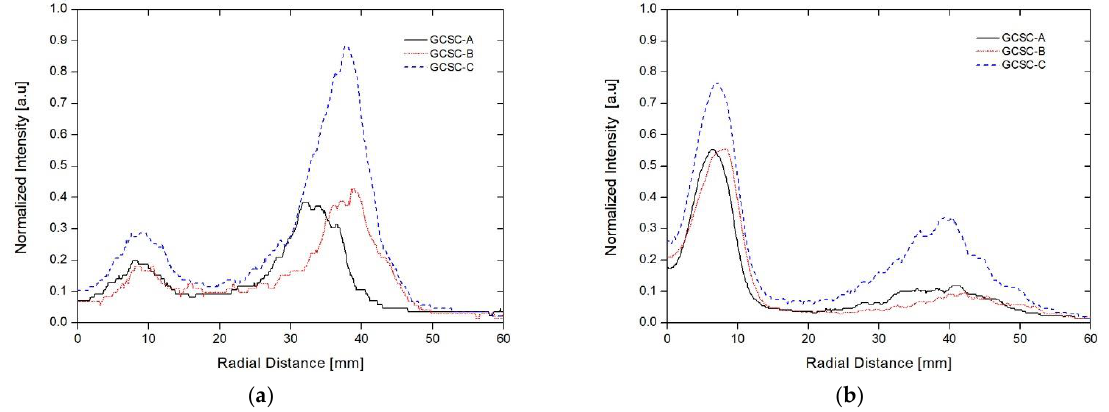
Figure 5. Spray distribution of the radial section at 30 mm from injector face: ( a ) MFR = 15; ( b ) MFR =